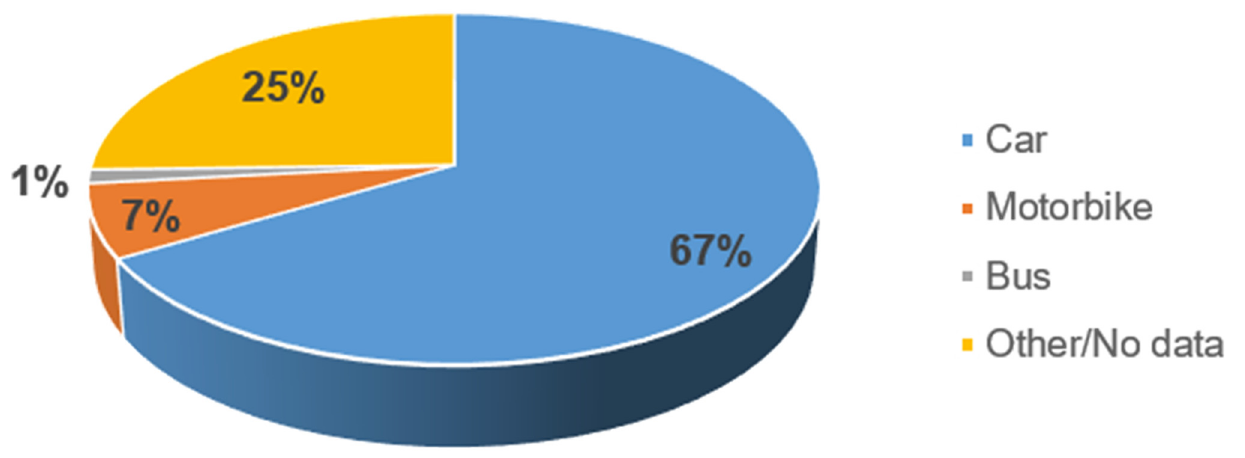
Figure 3. Distribution of teachers’ accidents per vehicle involved.